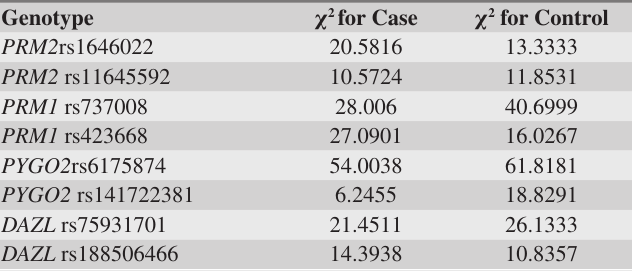
Table 5. Genetic Models of Single